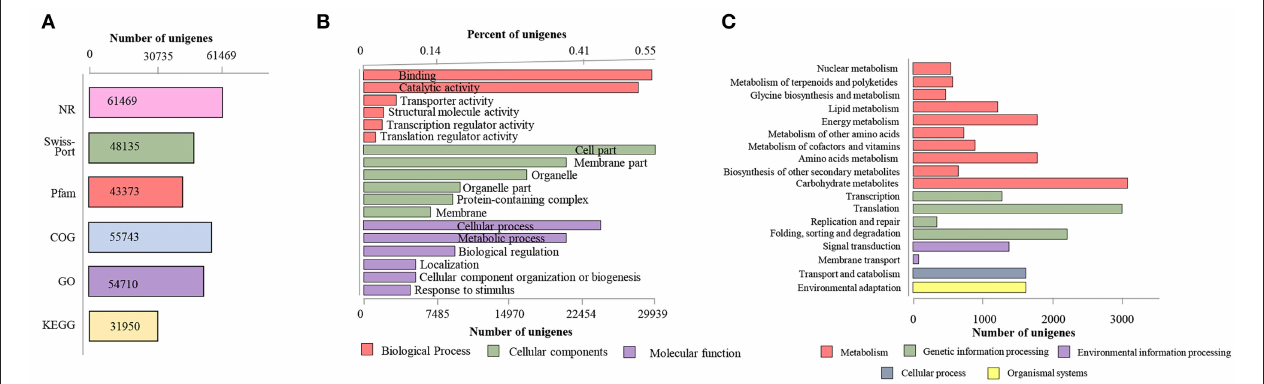
FIGURE 2 | General annotation of S. apiana transcriptome. (A) Annotation statistics searching against different data banks. (B) The most enriched Gene Ontology (GO) terms in three major functional categories. The top six terms of each category were represented. (C) The most enriched Kyoto Encyclopedia of Genes and Genomes (KEGG) pathways. Different databases, the GO categories, and the KEGG pathways are distinguished by colors.